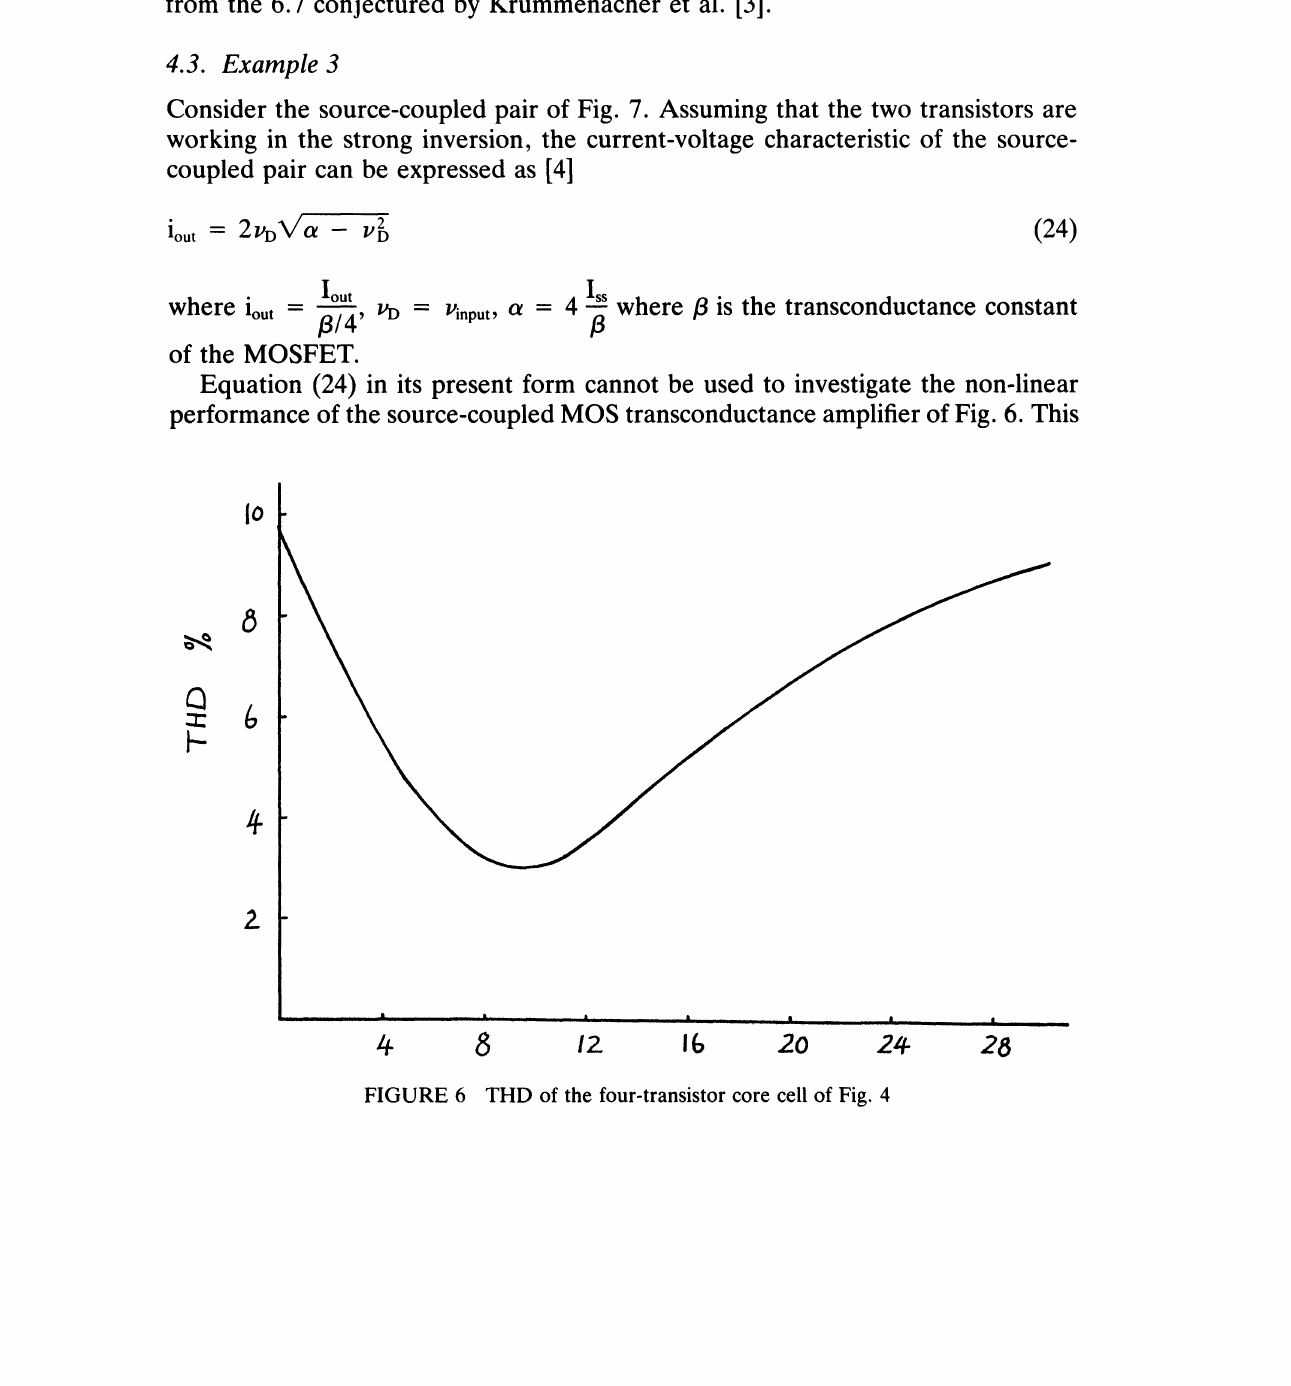
FIGURE 6 THD of the four-transistor core cell of Fig.